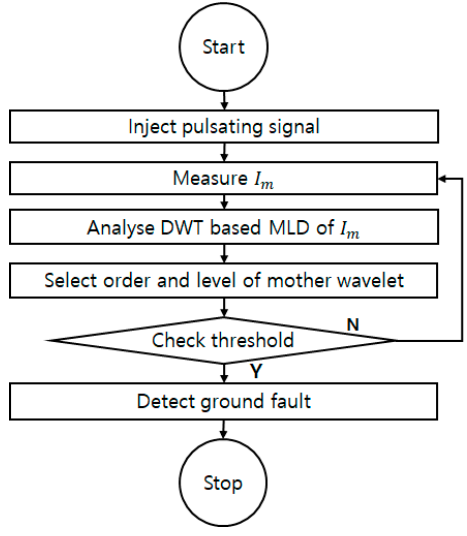
Figure 3. Flowchart of the proposed ground fault detection hybrid method.